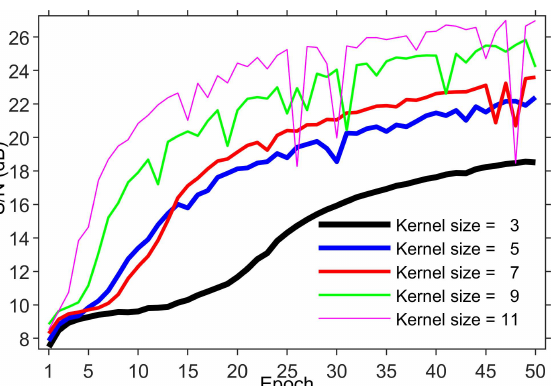
Figure 8. Variation in the S/N values of the DL prediction result with the number of epochs for 3D CNN’s validation processes with different sizes of the convolutional